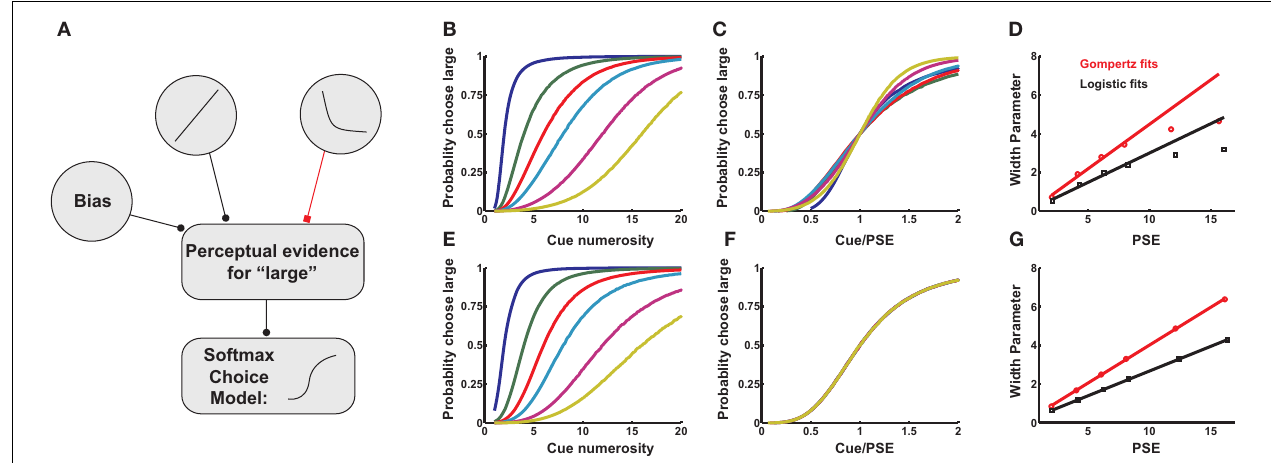
rightward, and the transition region interpolating between “small” and “large” classifi cations widens. (C) Choice curves from (B) , rescaled as a function of cue numerosity divided by PSE. Curves roughly overlap, indicating an approximate Weber’s Law behavior. (D) Width Parameter (width of the transition region, inversely related to discriminability) as a function of PSE. Red data points indicate parameters derived from fi tting choice curves with a Gompertz function, black points logistic fi ts (see Materials and Methods). Lines are fi tted to the fi rst four data points, and show a deviation from linearity at high PSE, predicting a departure from Weber’s Law. Slopes of lines are equal to Weber fractions calculated in the models. (E–G) Same as (B–D) , except tuning curve inputs to (A) are modeled as positive and negative logarithms. As expected, Weber’s Law holds to all